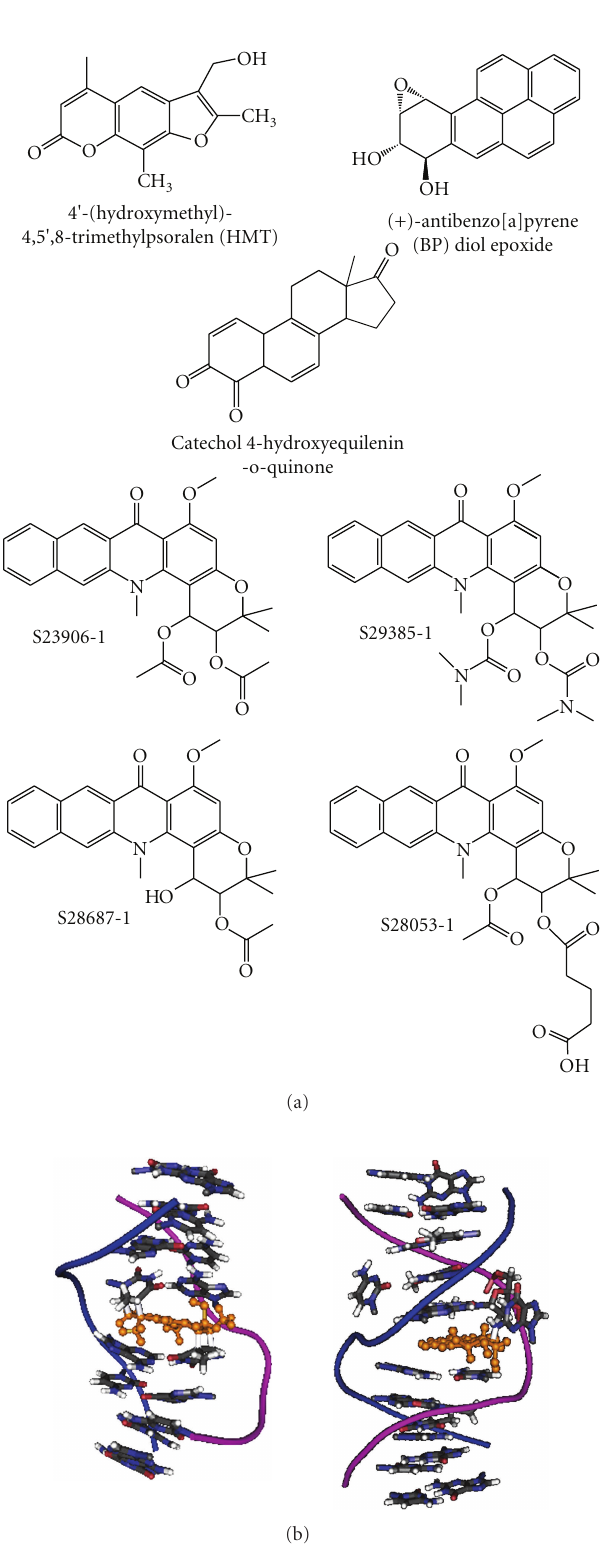
Figure 5: Other DNA alkylating agents inducing local destabi- lization of the DNA helix. (a) Structures of some DNA alkylating molecules that destabilize the DNA helix. (b) Three-dimensional organization of the psoralen derivative HMT (a) and (+) -anti- BPDE (b) bound to DNA (crystallographic data [mmdbId:52343] [118] and [mmdbId:52106], respectively,